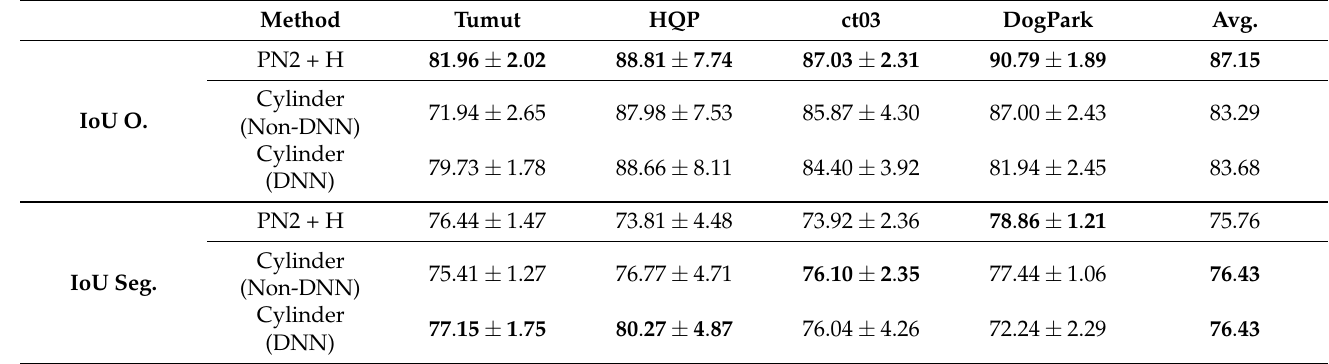
Table 5. We compare the overall IoU (IoU O.) and average IoU over height segments (IoU Seg.) between two variants of our cylinder segmentation model and our best-supervised backbone segmen- tation model under the supervised setting. Our cylinder (Non-DNN) variant is based on the cylinder parameters directly produced by the non-DNN fitting method in [10], while our cylinder (DNN) vari- ant is based on the cylinder parameters estimated using our DNN-based tree parameter estimation model. We report the average results and standard deviations over the three different training and validation splits for each dataset and we highlight the best result across different methods on each dataset (in bold).